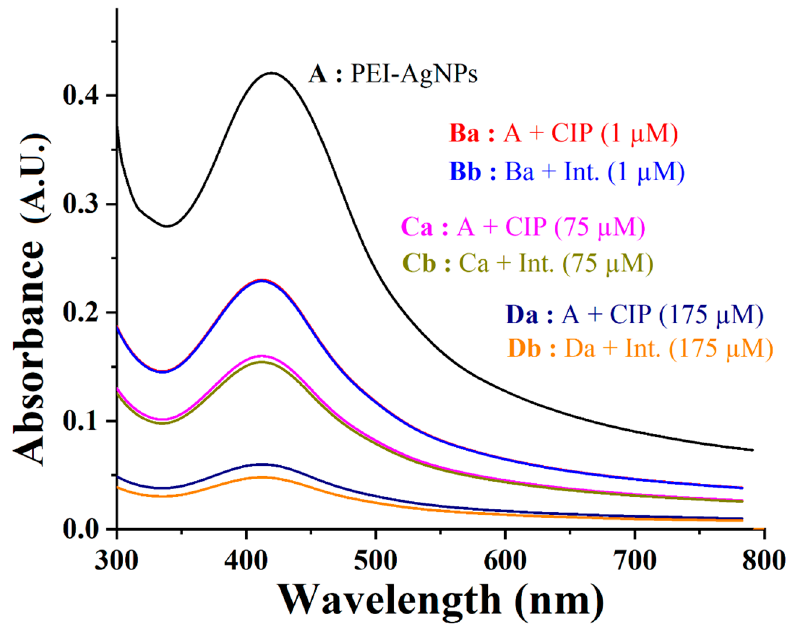
Figure 6. The quantitative effect of interfering drugs on CIP sensing by PEI-AgNPs through UV-Vis spectrophotometry, wherein A represents PEI-AgNPs; addition of different amounts of CIP in PEI-AgNPs is represented by Ba, Ca, and Da; addition of CIP to PEI-AgNPs along with the same amount of the interferents is represented by Bb, Cb, and Db. Individually added interferents were cefixime, aspirin, cephradine, diazepam, promethazine, levetiracetam, neomycin, cefaclor, theophylline,